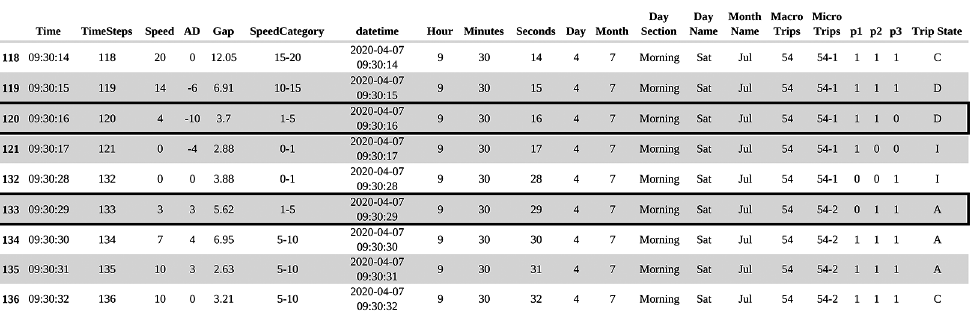
Figure 9. The start and end of micro-trip within the data frame